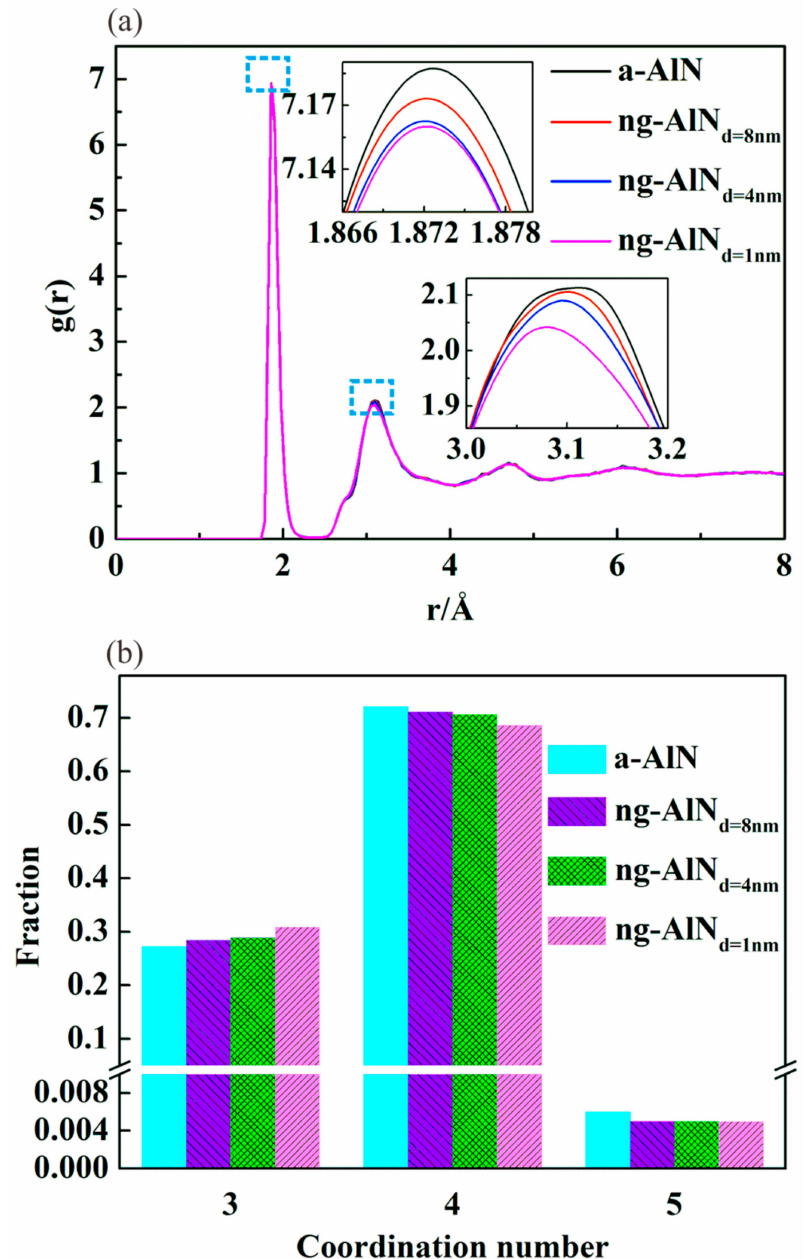
Figure 2. ( a ) Radial distribution functions (RDFs), ( b ) Coordination number of a-AlN, ng-AlN d = 8 nm , ng-AlN d = 4 nm , and ng-AlN d = 1 nm ,